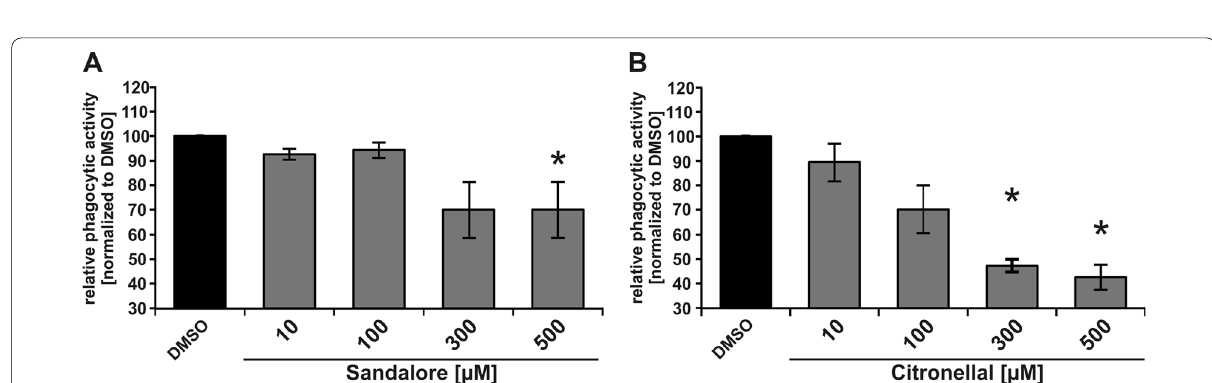
Fig. 4 Sandalore and Citronellal increase the cAMP levels. AM were stimulated for 20 min with Sandalore ( A ) or Citronellal ( B ) at the indicated concentrations. The intracellular cAMP concentration was normalized to the solvent control (DMSO). Data (n mean SEM and were analyzed using the Friedman test with post hoc “Two-stage-up method of Benjamini, Krieger, and Yekutieli,” referring to the ± solvent control. **p 0.01 ≤